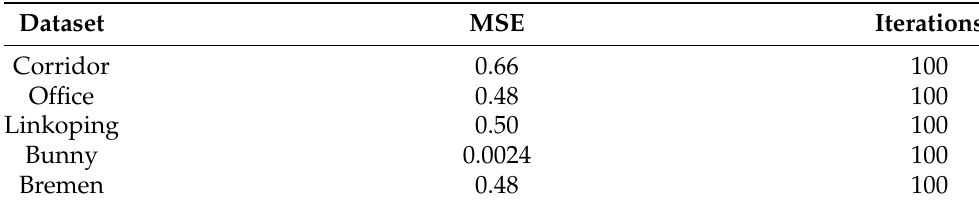
Table 2. Experimental results with fixed number of